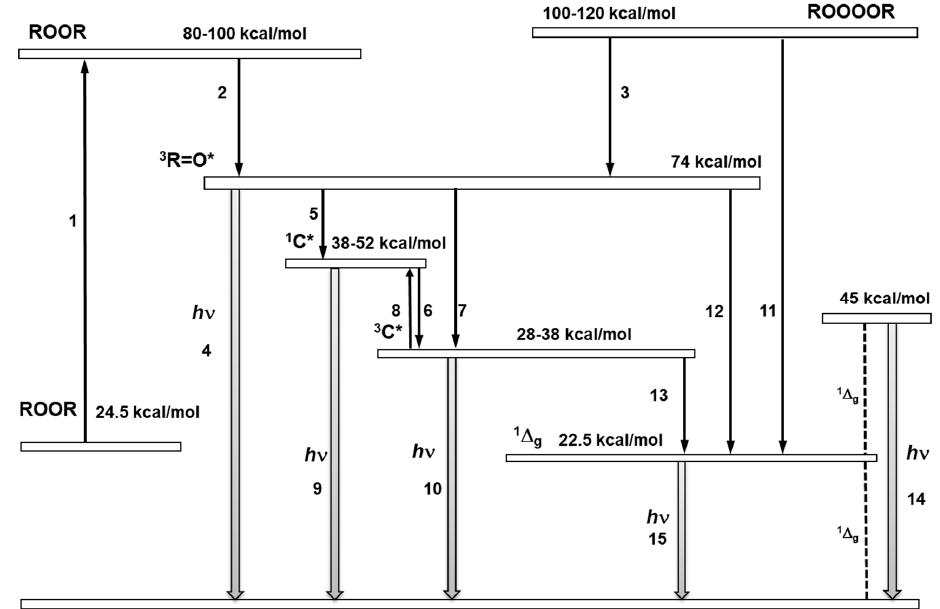
Figure 7. Schematic energy level diagram of the formation of electronically excited species through the decomposition of ROOR and ROOOOR. The decomposition of ROOR occurs via a transition state (reaction 1). The decomposition of the transition state of ROOR generates 3 R=O * (reaction 2). The decomposition of ROOOOR to 3 R=O * (reaction 3). The electronic transition from the triplet energy level of 3 R=O * to the ground state is accompanied by light emission (reaction 4). The triplet-singlet energy transfer from 3 R=O * to 1 C * (reaction 5). The triplet-triplet energy transfer from 3 R=O * to chromophore 3 C * (reaction 6). Intersystem crossing from 1 C * to 3 C * (reaction 6). The reverse intersystem crossing converts 3 C * to 1 C * (reaction 8). The electronic transition from 1 C * and 3 C * to the ground state is accompanied by photon emission (reaction 9,10). The decomposition of ROOOOR generates singlet oxygen ( 1 Δ g ) (reaction 11). The triplet-singlet energy transfer from 3 R=O * to molecular oxygen is feasible (reaction 12). The electronic transition from the energy level of singlet oxygen ( 1 Δ g ) to the triplet energy level of ground state is accompanied by dimol (reaction 14) and monomol photon emission (reaction 15).